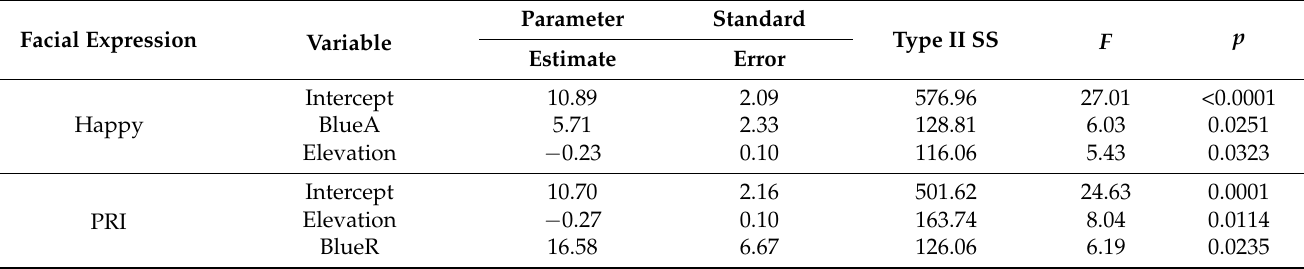
Table 4. Multivariate linear regression of happy and positive response index (PRI) scores (ranked transformed) against blue-space area and elevation in wetland parks.